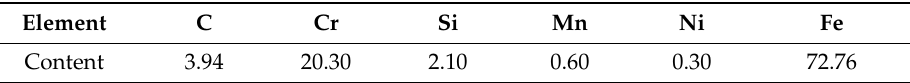
Table 1. Chemical composition of hypereutectic high chromium cast iron (wt%). Element